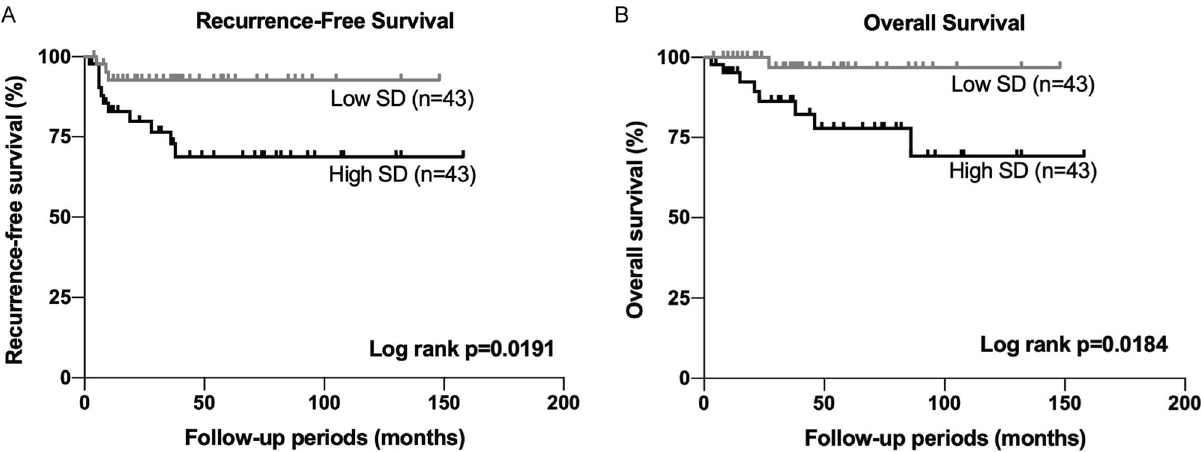
Figure 3. The survival analysis according to SD in UTUC. ( A ) Kaplan–Meier analysis for RFS according to SD. ( B ) Kaplan–Meier analysis for OS according to SD. SD = standard deviation, UTUC = upper tract urothelial carcinoma, TA = texture analysis, RFS = recurrence-free survival, OS = overall